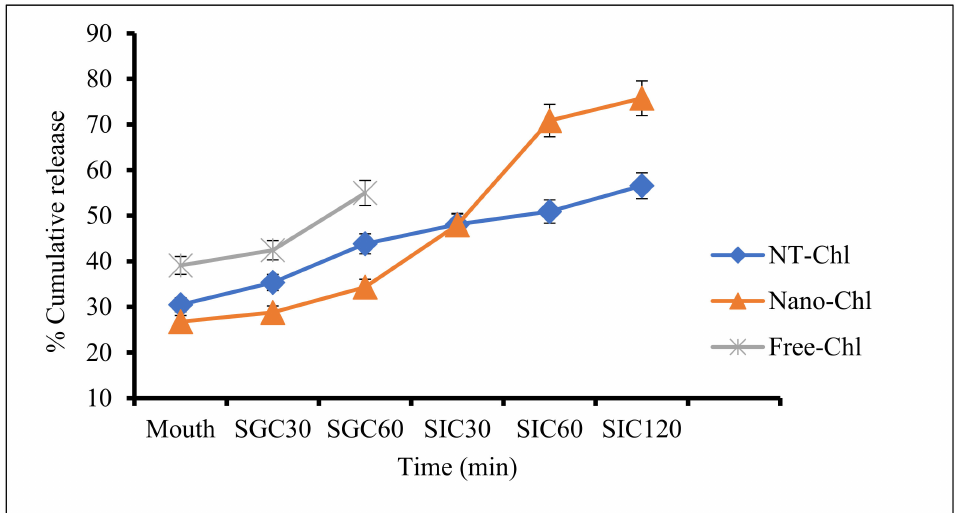
Figure 4. Release pattern of Free-Chl, NT-Chl, and Nano-Chl under simulated gastrointestinal conditions, where SGC (simulated gastric condition) is at 30 and 60 min of incubation and SIJ (simulated intestinal condition) is at 30, 60, and 120 min of incubation. Key: For caption, see Figure